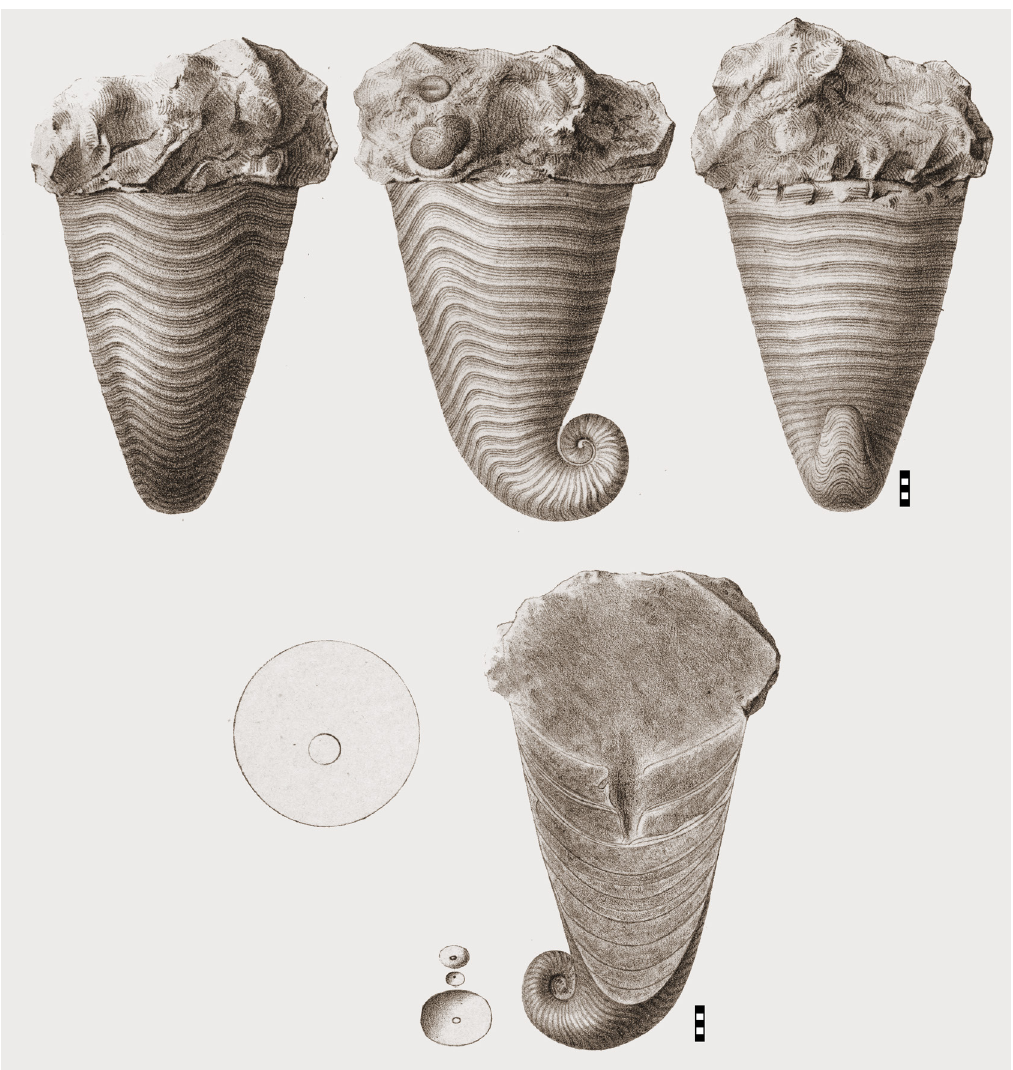
Fig. 24. Ancistroceras torelli (Remelé, 1881) from the Upper Grey Orthoceratite Limestone. Reproduction of the illustration of lectotype MB.C.22575 from Heegermühle (Brandenburg) from Remelé (1890: pl. 4 fig. 1). Scale bar units = 1